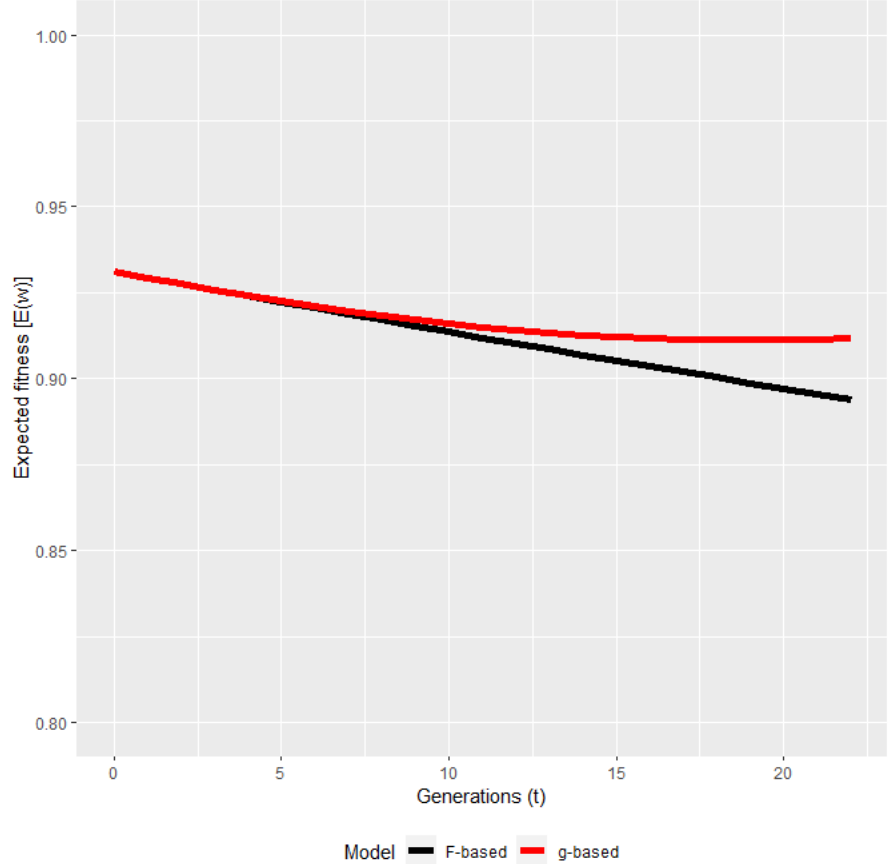
Figure 2. The predicted fitness based on the Wright (F) and on the purged (g) inbreeding coefficients.